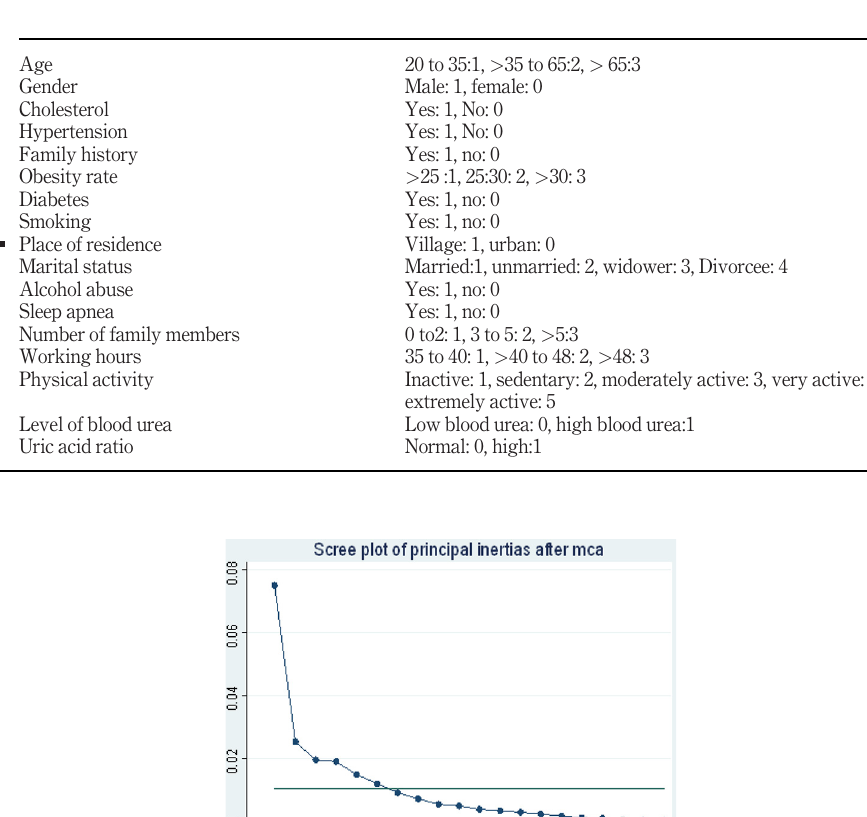
Figure 1. Scree plot of eigenvalues obtained from MCA